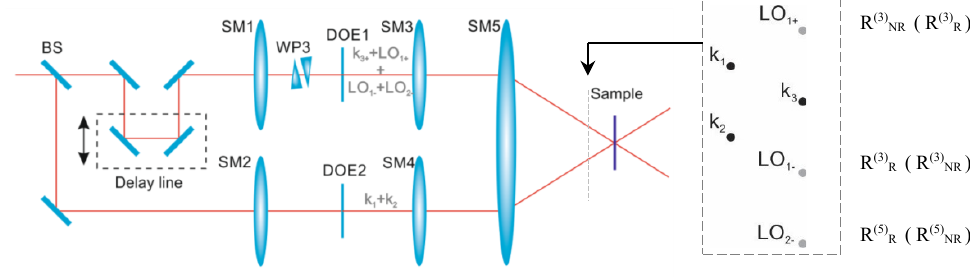
Fig. 1. (a) Schematics of the experimental setup. DOE – diffractive optic element; WP – wedge pair, SM – spherical mirror, BS – beam splitter (b) Actual boxcar geometry for measuring R (3) and R (5) - signals, heterodyned with local oscillators LO 1- , and LO 2- , respectively. Depending on the relative time-ordering of k 1 ( k 2 ), the measured 2D spectra are either of rephasing (index R) or non-rephasing (NR) character, but emitted along the same phase-matching